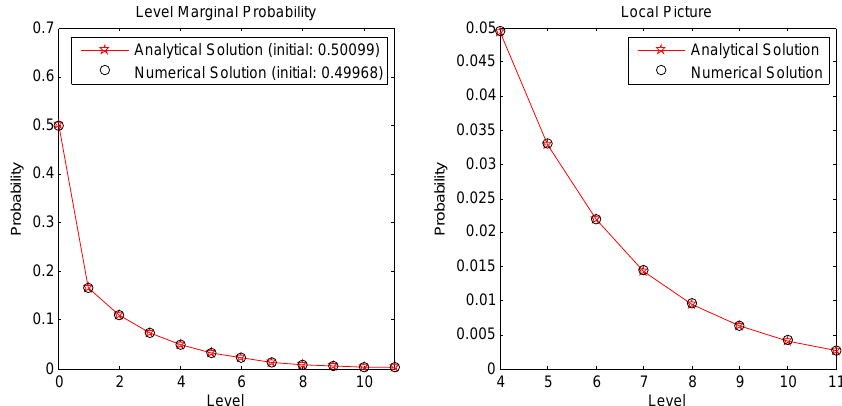
Figure 2. Level marginal invariant probability distribution L Π k .